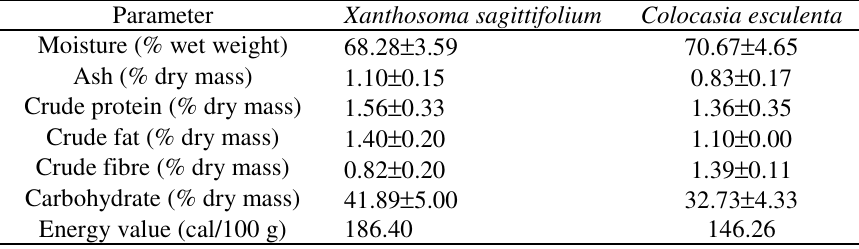
Table 1. Proximate composition of cocoyam